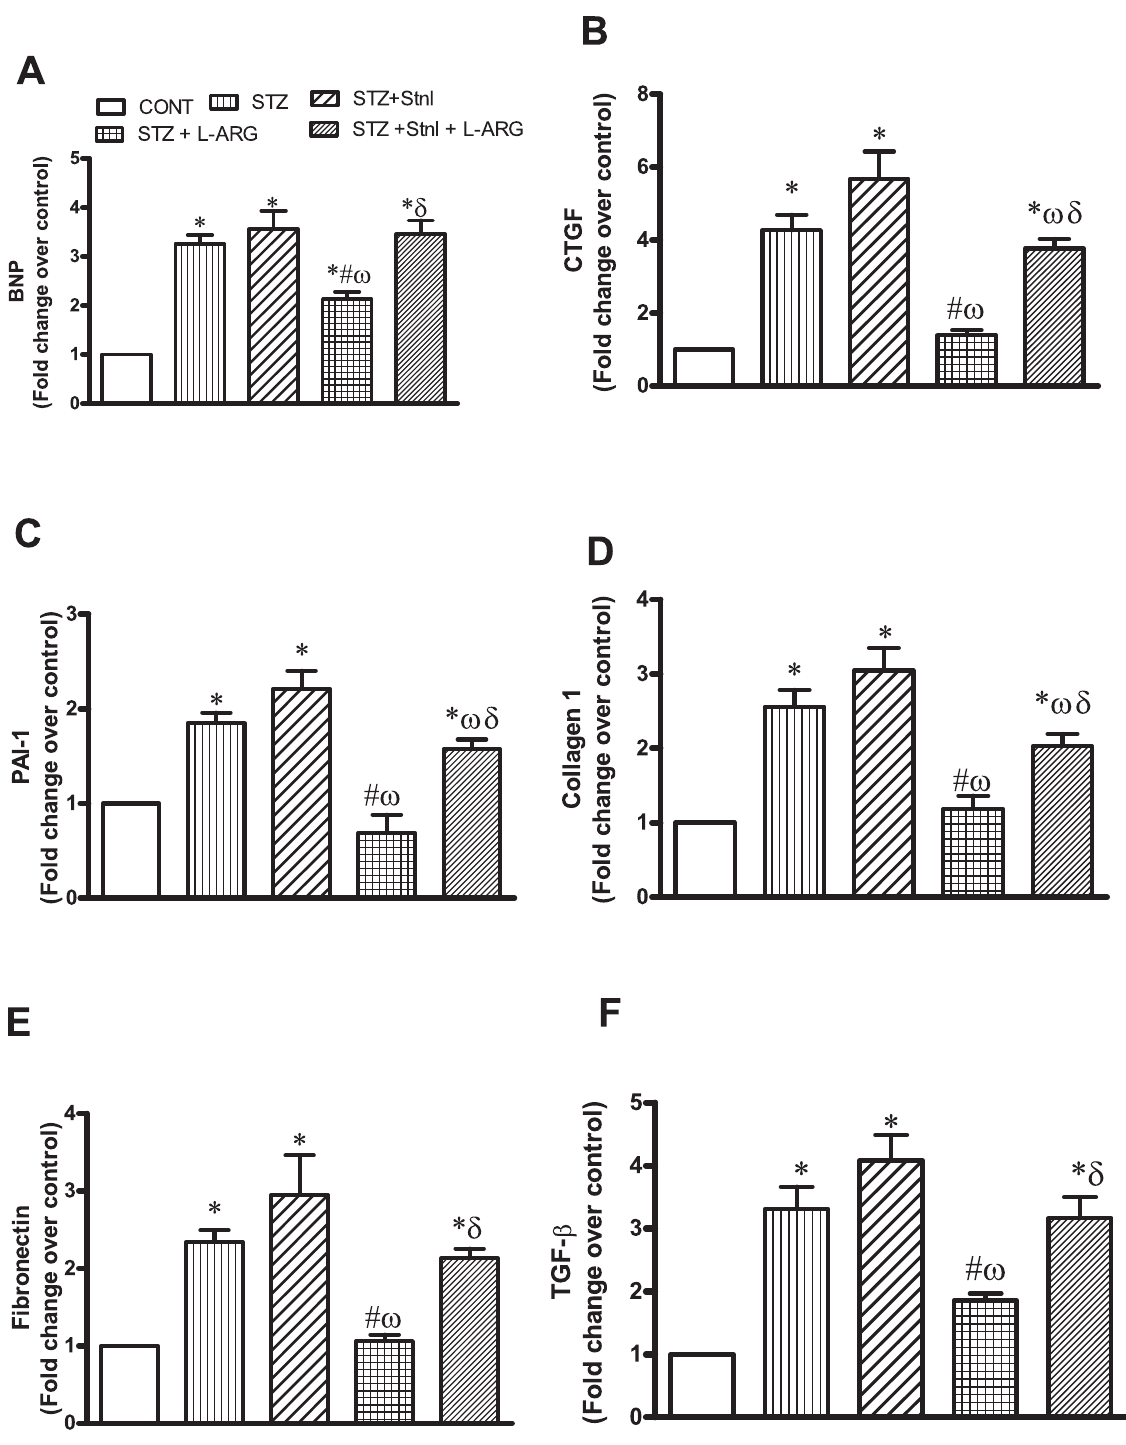
Fig. 2. Effect of STZ alone or in combination with L-ARG on or L-ARG + Stnl: A-brain naturetic peptide (BNP), B- connective tissue growth factor (CTGF), C-Plasminogen activator inhibitor-1 (PAI-1), D-collagen-1, E-fibronectin and tansforming growth factor (TGF)- b . Data represent the means of six experiments ¡ SEM; *, # , v and d P , 0.05 compared with CONT, STZ, STZ + Stnl and STZ + Stnl + L-ARG, respectively, using one-way ANOVA followed by Tukey’s Multiple Comparison Test.